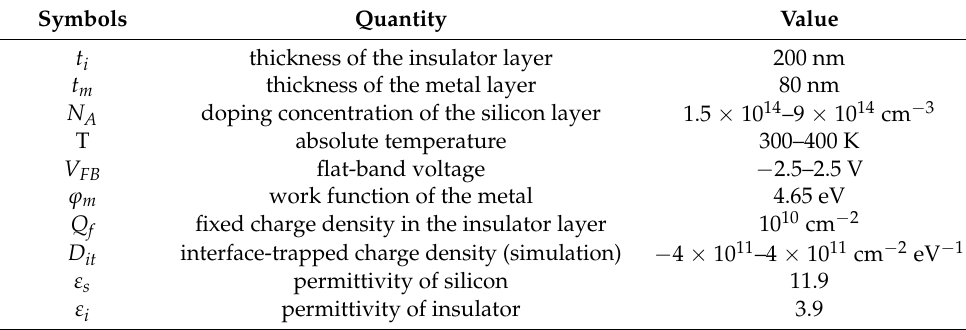
Table 1. Structural parameters and values of the stacked bonding structure.